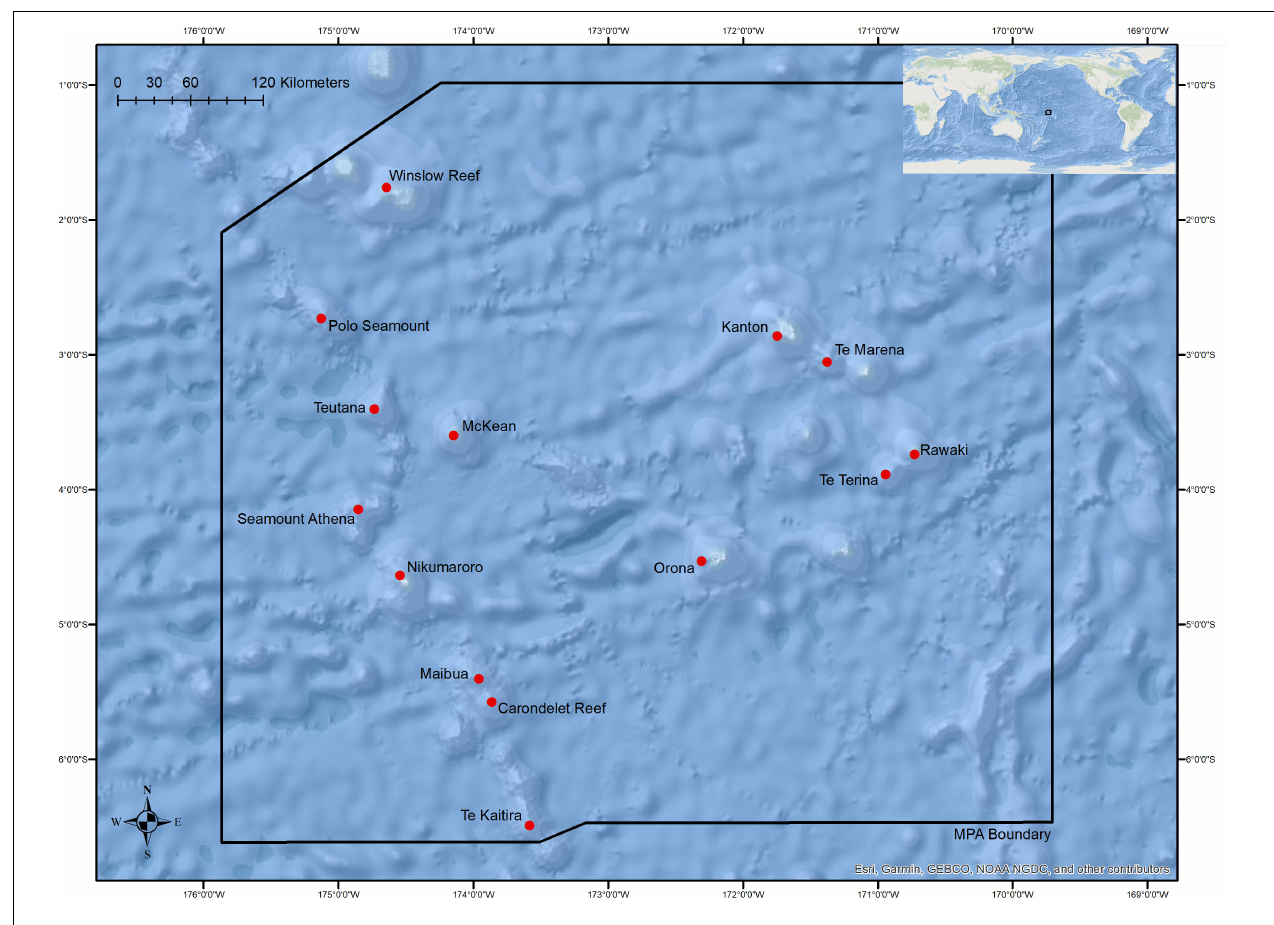
FIGURE 1 | Overview of the boundaries of the Phoenix Islands Protected Area with locations of sites where dives were conducted in this study. Table 1 and Supplementary Figure S1 provide detailed dive site names, coordinates, and depth